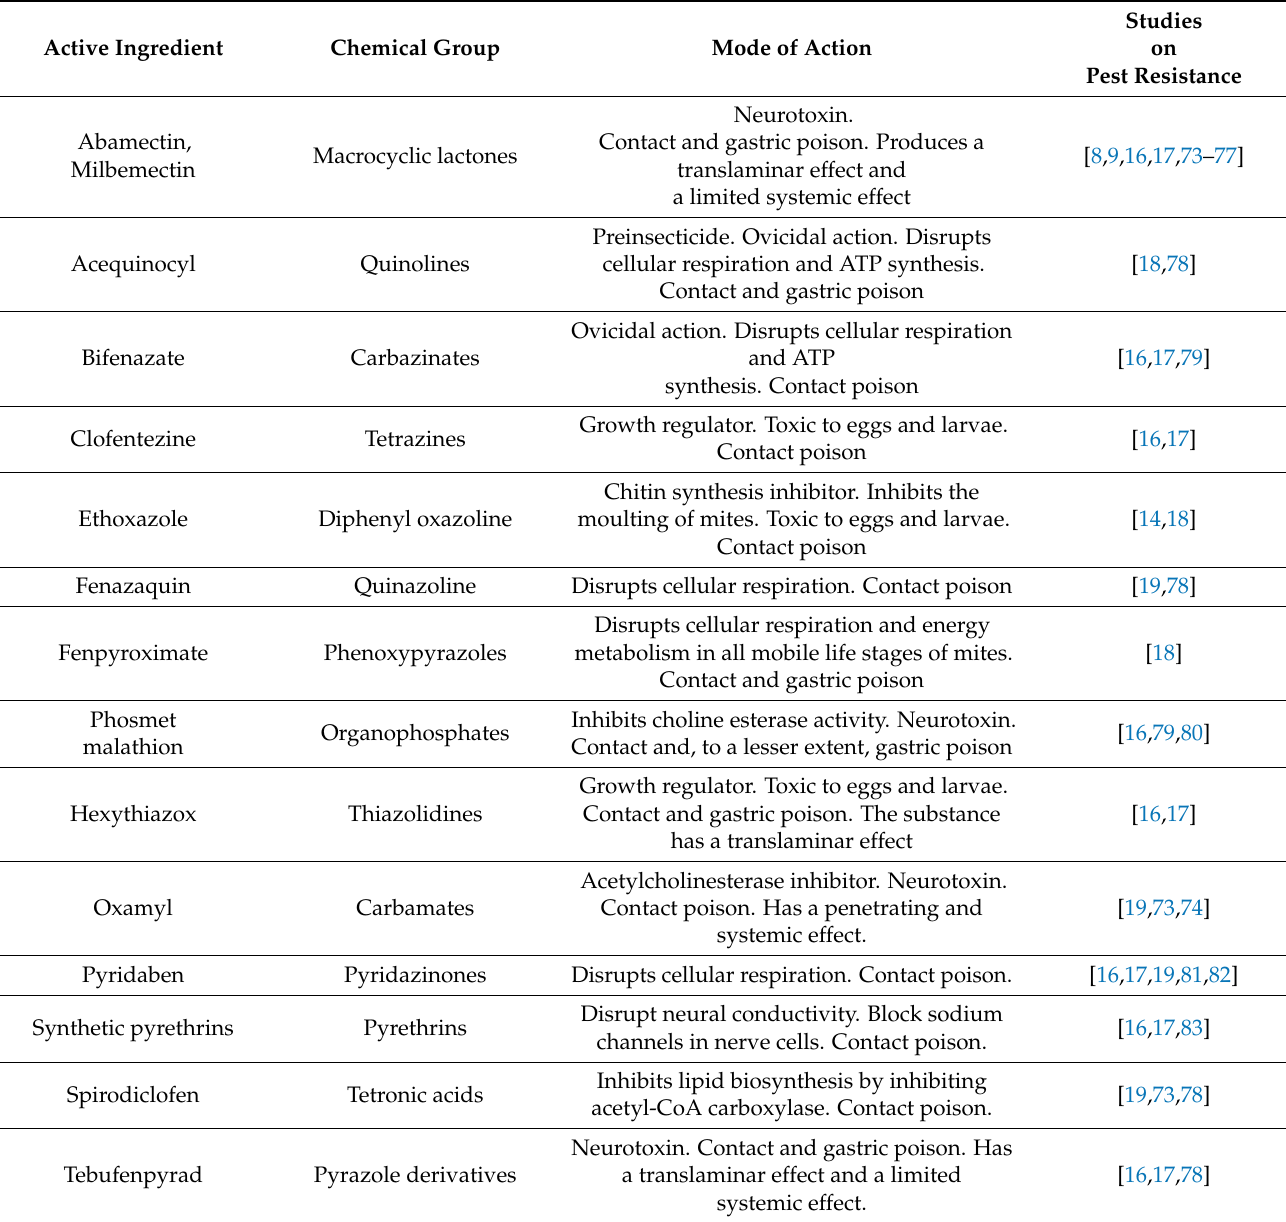
Table 1. Synthetic acaricides that have been used for controlling T. urticae